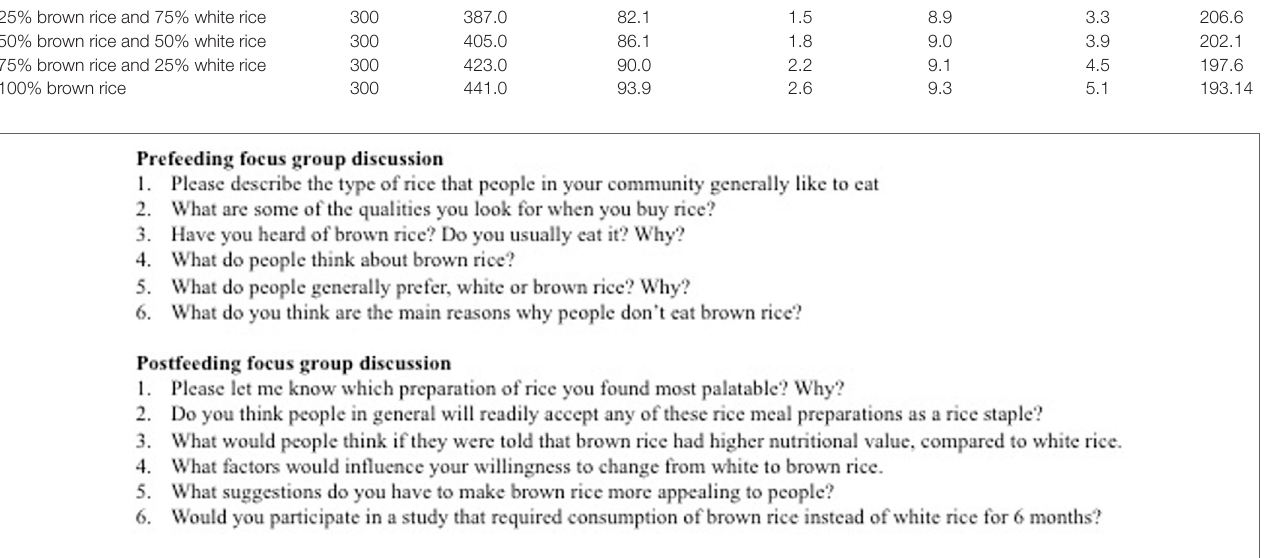
FigUre 2 | Sample questions asked during the focus group discussions.